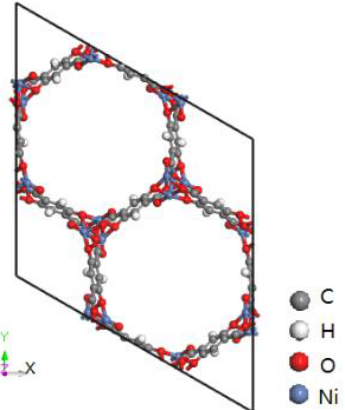
Figure 1. Schematic view of the 1 × 1 × 1 unit cell of metal organic framework MOF-74 (M = Ni).